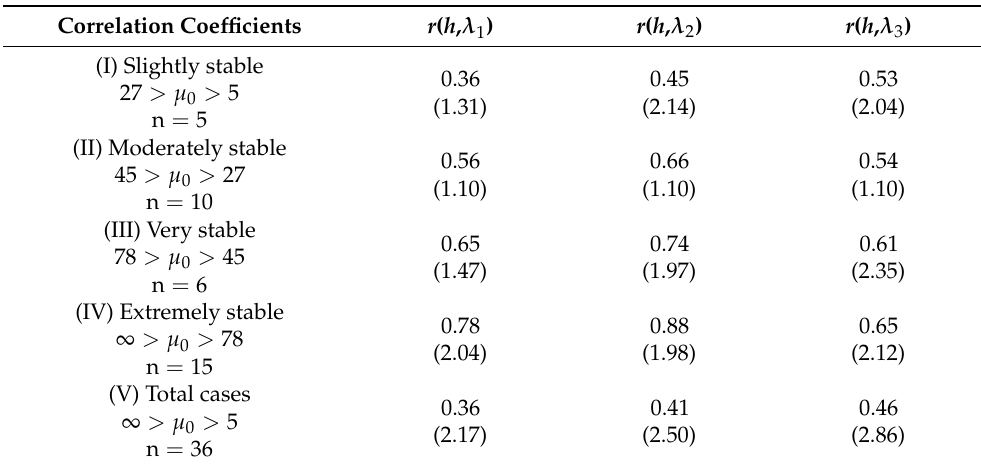
Table 1. Correlation coefficients ( r values) between h and the diagnostic height parameters. The corresponding Z values are in